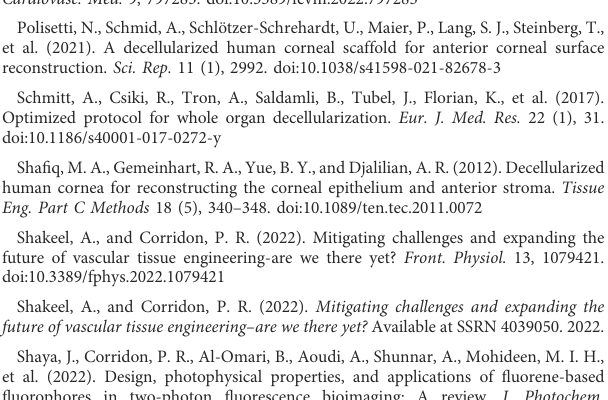
economic practices. Figshare . doi:10.6084/m9. fi